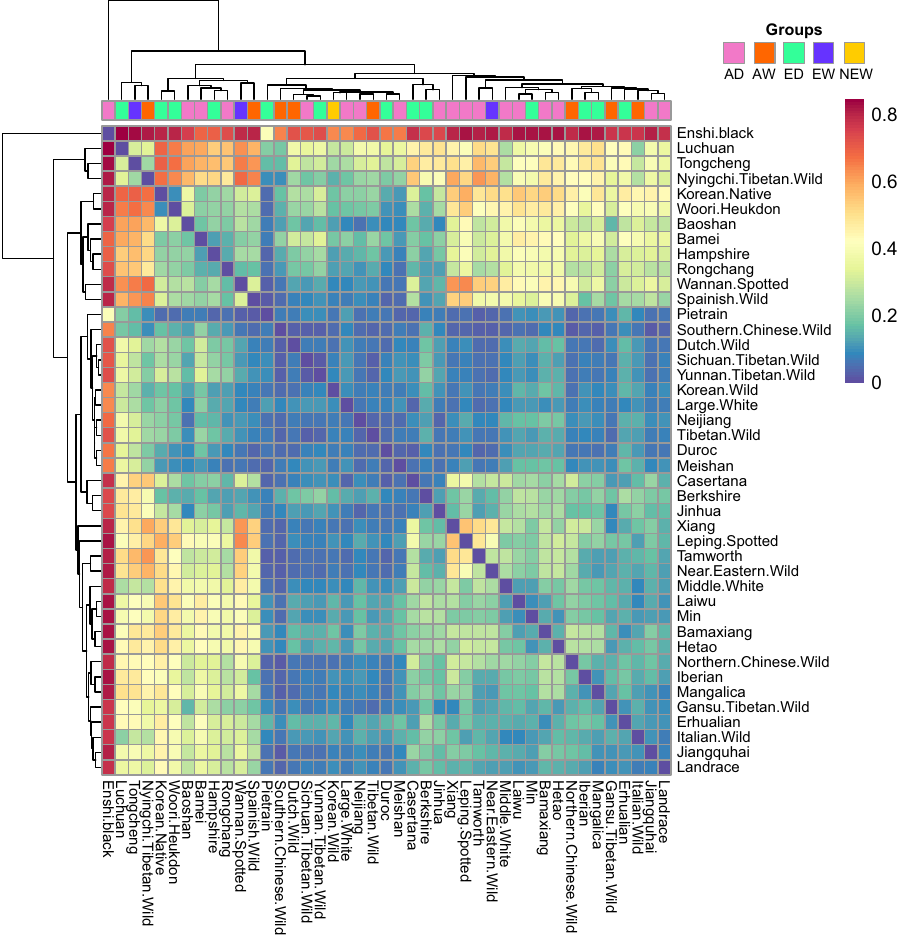
Figure 2. Average of pairwise V ST between breeds. Average of pairwise V ST of genes on autosomal CNVRs were calculated between all pairs of breeds which included more than 1 sample. Clustering were performed only on the mean pairwise V ST